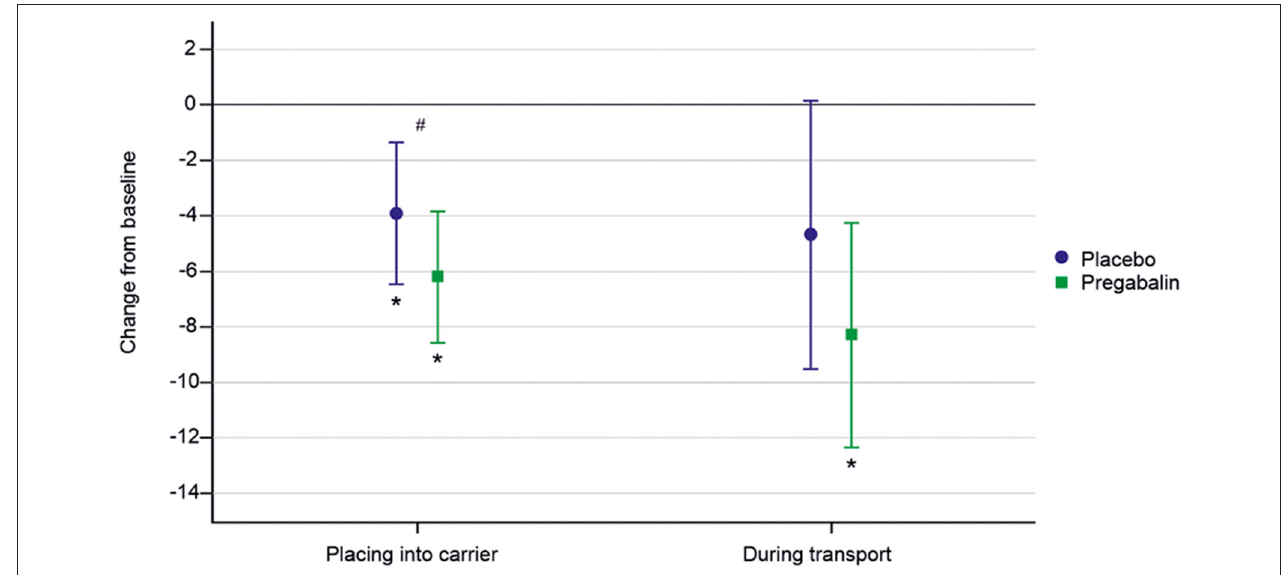
FIGURE 3 | Model-based estimates of mean (95% CI) change from baseline in owner’s assessment of signs of distress, anxiety, and/or fear. Pregabalin 5 and 10 mg/kg groups combined. *Indicates a significantly different value compared to baseline. # Indicates a significant difference between